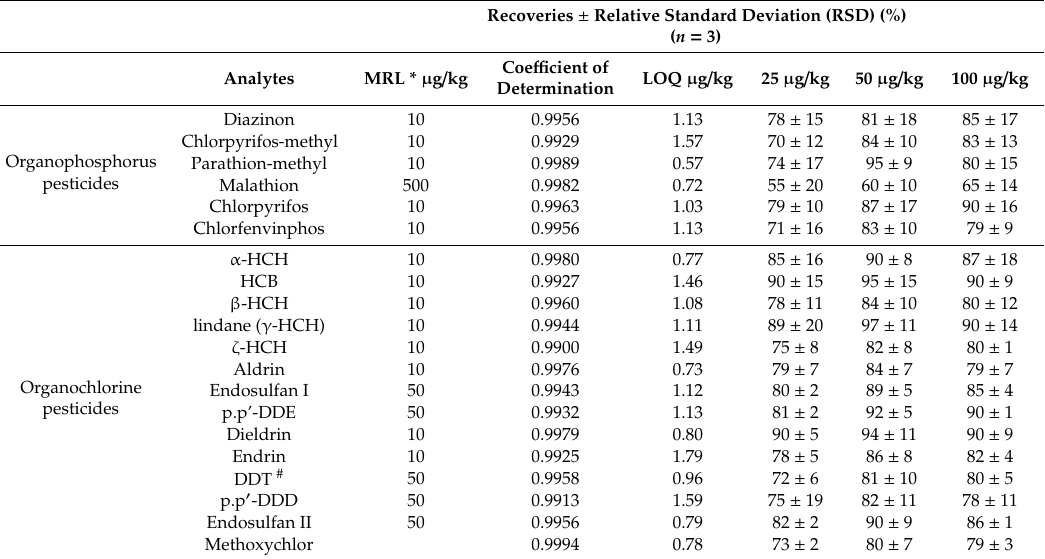
Table 4. Analytical performance for organochlorine (OCP) and organophophorus pesticides OPPand in lettuce matrix using the proposed